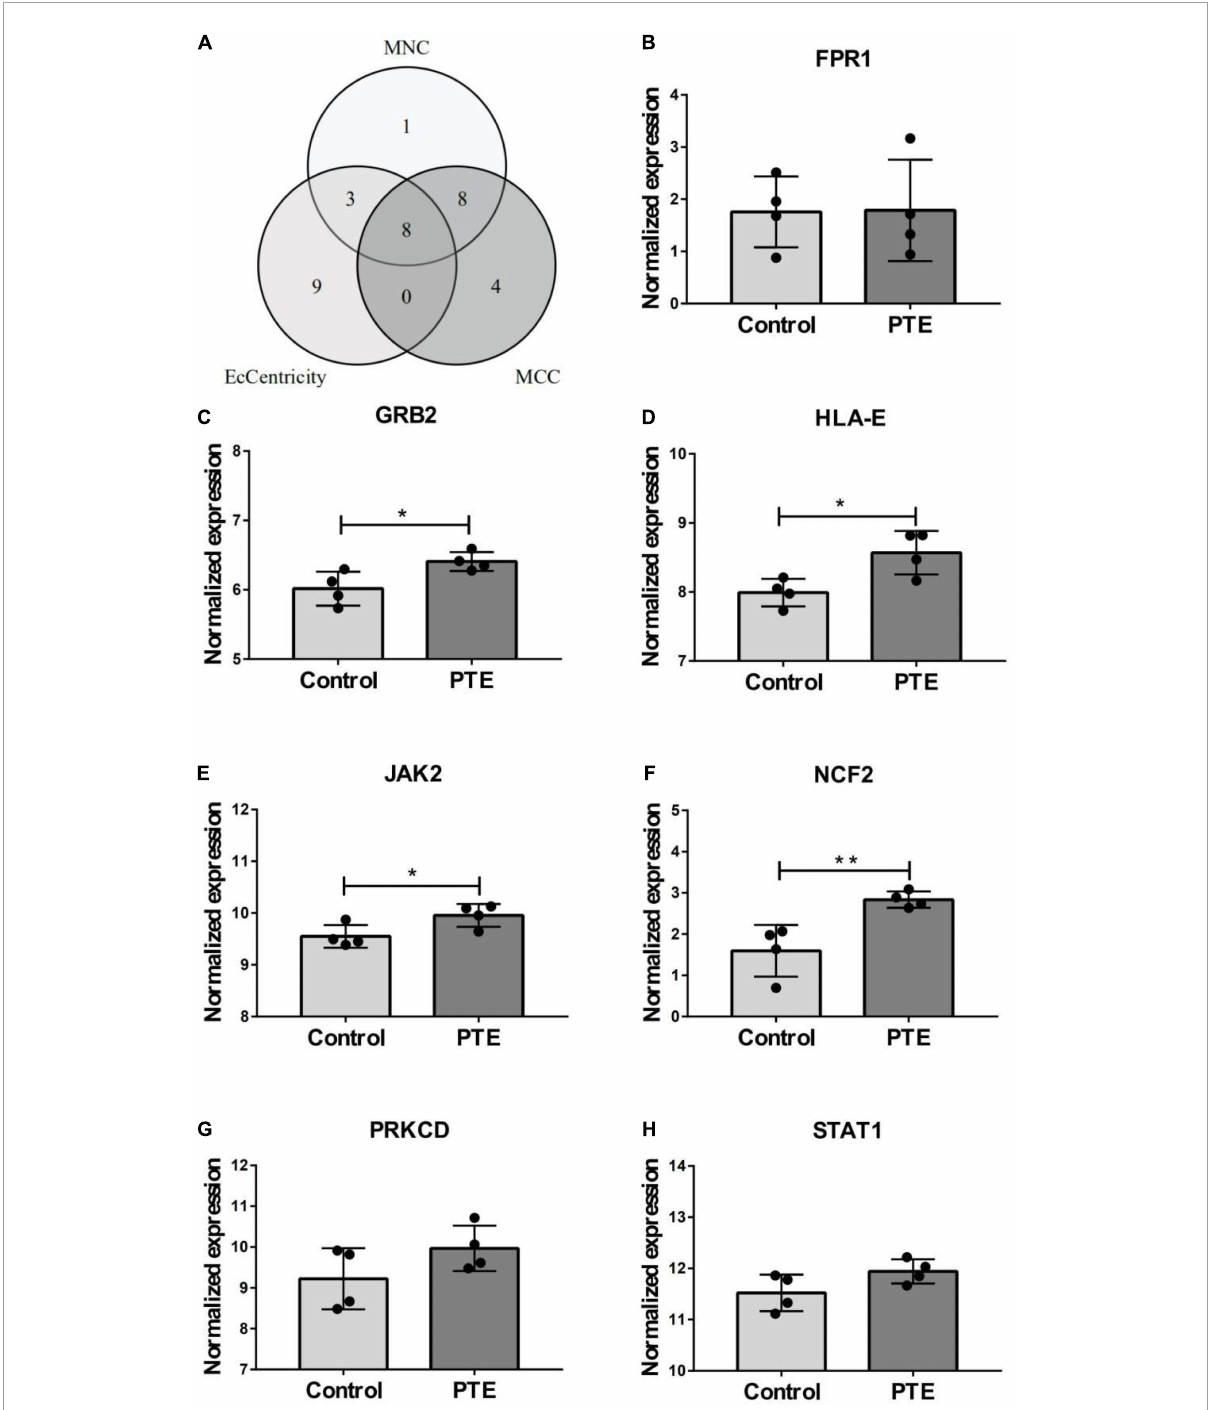
FIGURE4 Identification and expression level of hub gene. (A) The Venn diagram of three algorithms. (B–H) The expression level of hub gene in GSE40490. The comparison between the two sets of data uses the mean t -test. * p < 0.05; ** p < 0.01.